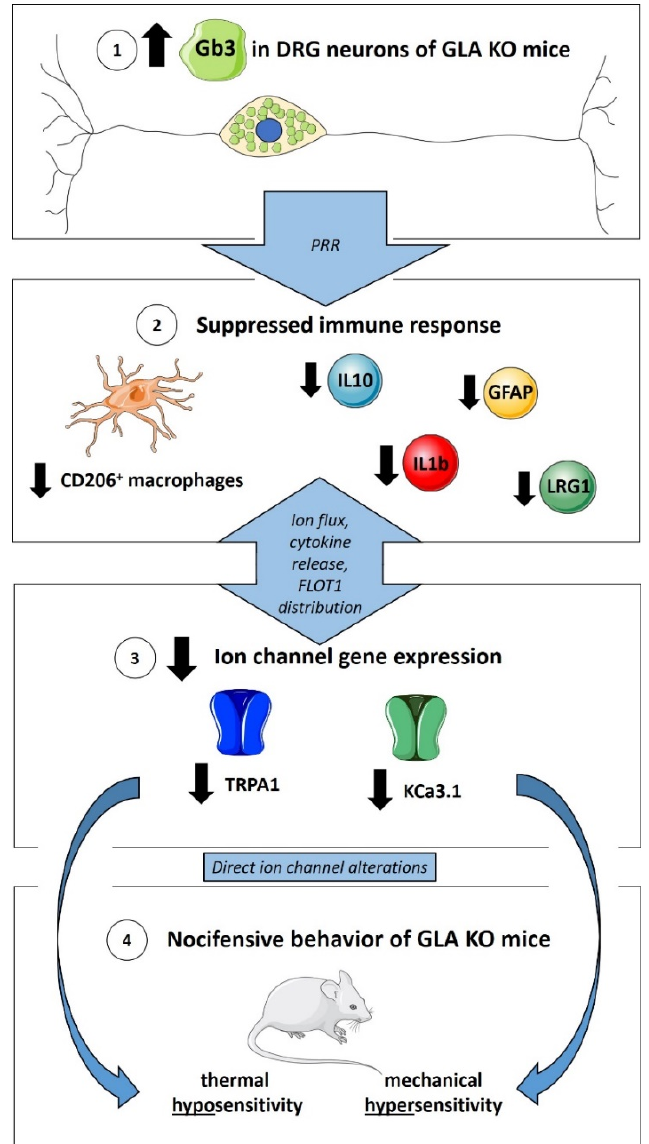
Figure 9. Suppressed immune response and ion channel gene expression in murine DRG of